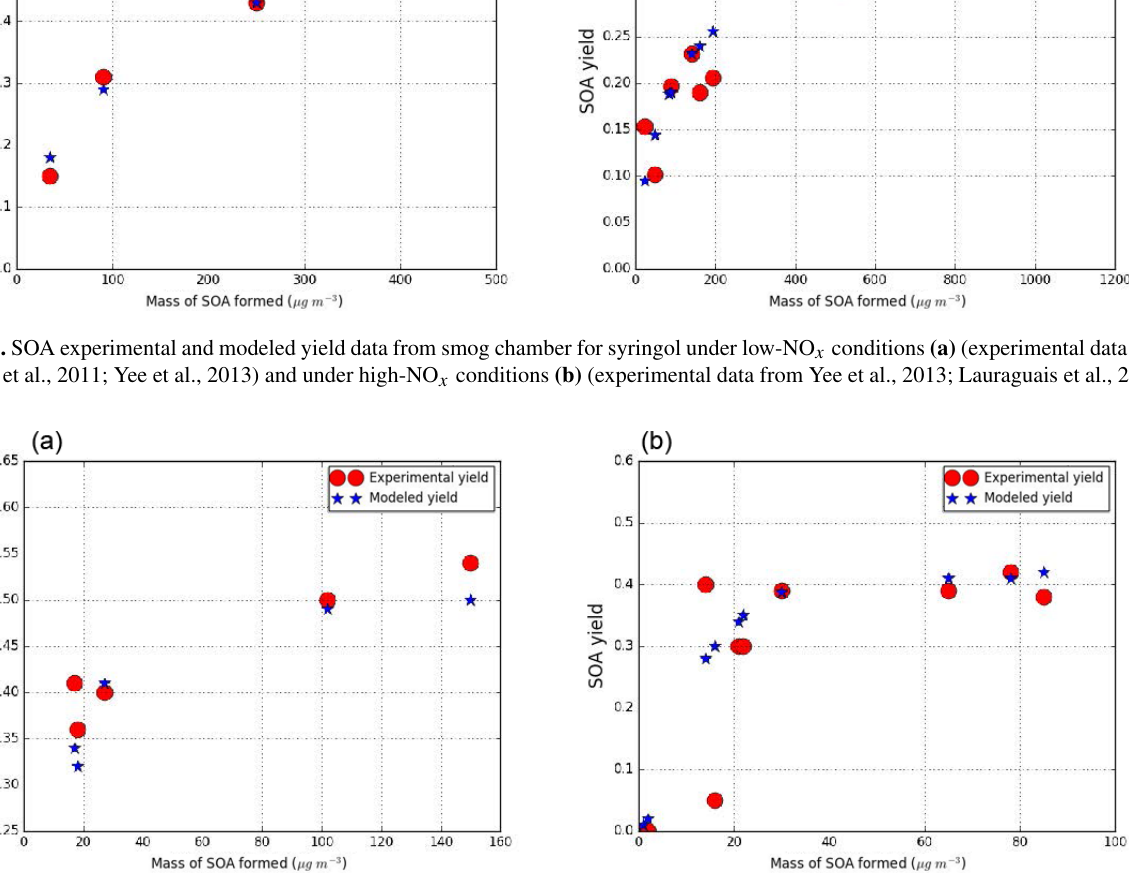
Figure 4. SOA experimental and modeled yield data from smog chamber for guaiacol under low-NO x conditions (a) (experimental data from Chhabra et al., 2011; Yee et al., 2013) and under high-NO x conditions (b) (experimental data from Yee et al., 2013; Lauraguais et al.,